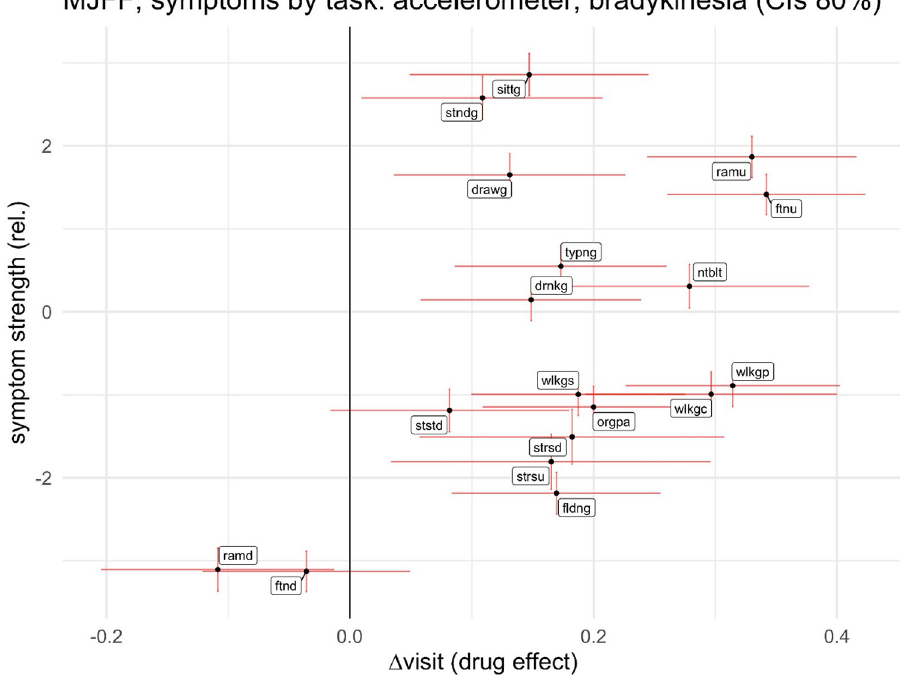
Fig 7. Drug effect on the symptom severity as predicted from the accelerometer data (x-axis), and relative strength of the effect (y-axis at different tasks in MJFFd.